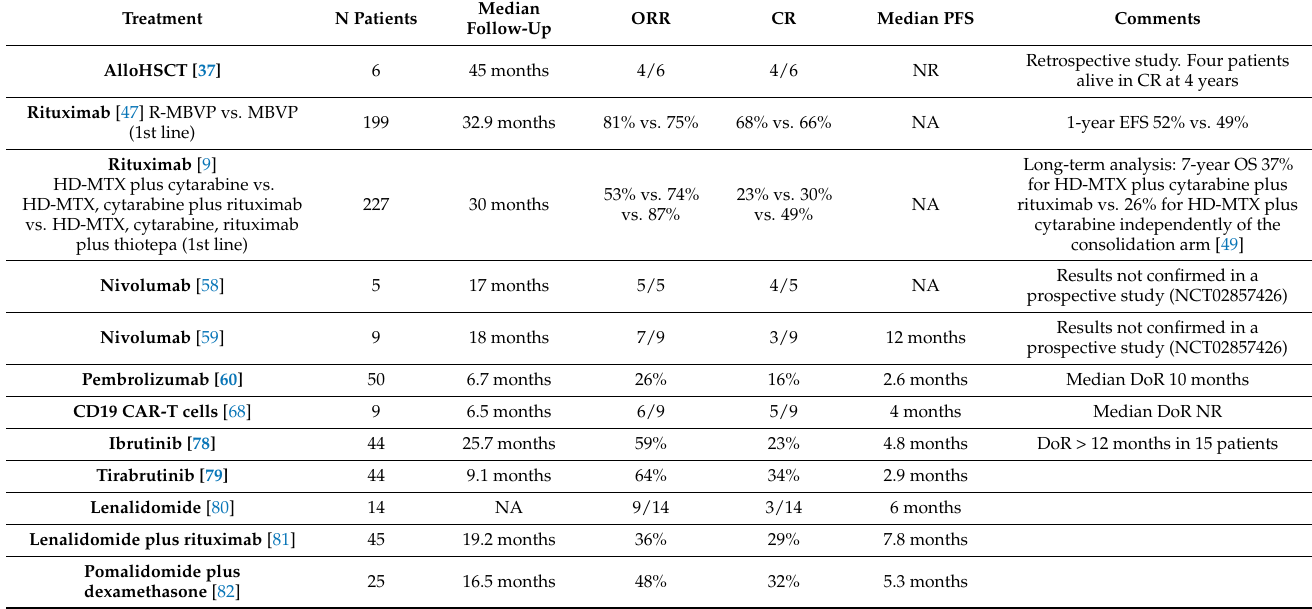
Table 1. Summary of the main clinical data on PCNSL immunotherapies. ORR, overall response rate; CR, complete response; PFS, progression-free survival; alloHSCT, allogeneic hematopoietic stem cell transplantation; NR, not reached; vs., versus; NA, not available; EFS, event-free survival; HD-MTX, high-dose methotrexate; DoR, duration of response. Treatment N Patients Median